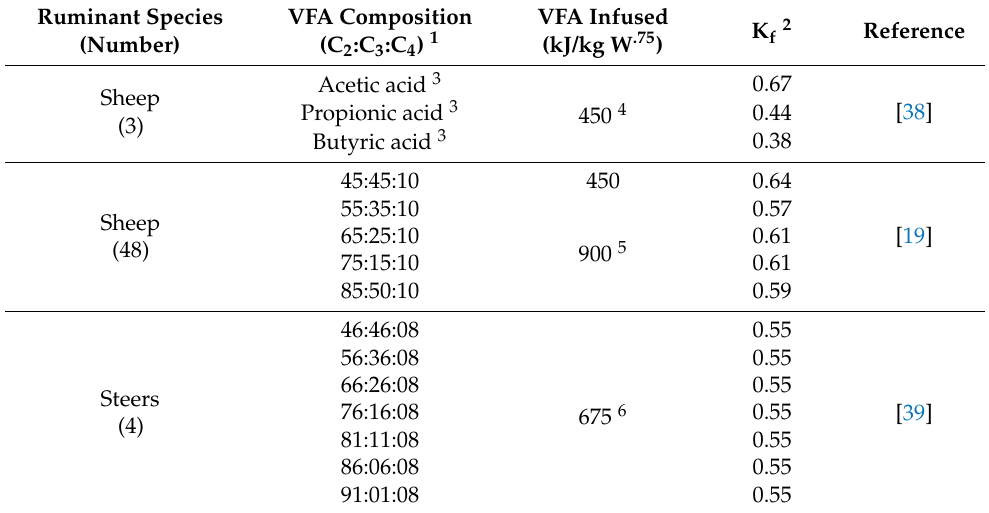
Table 3. Efficiency of utilisation of volatile fatty acids (VFA) for energy retention (K f ) in ruminants. Ruminant